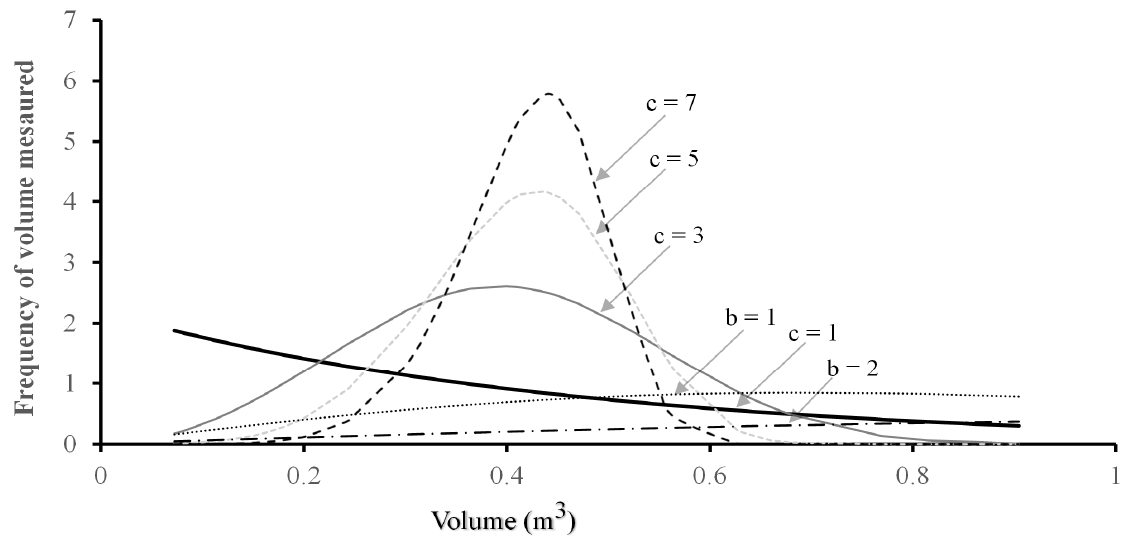
Figure 4. Weibull distribution based on obtained volume data.